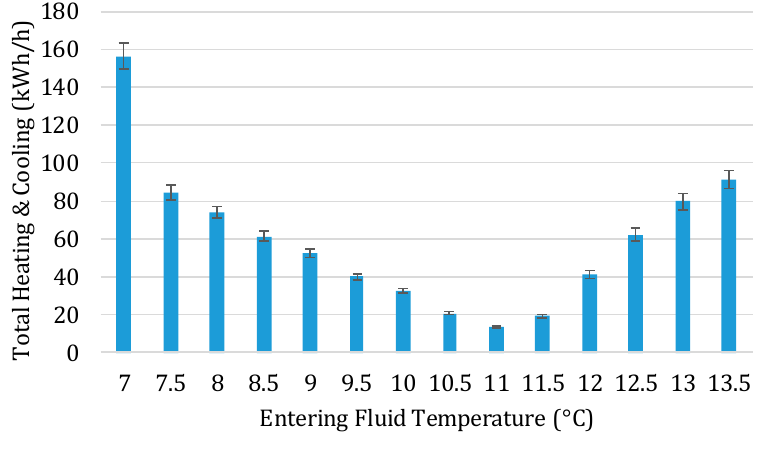
Figure 10. Overall load vs. EFT.